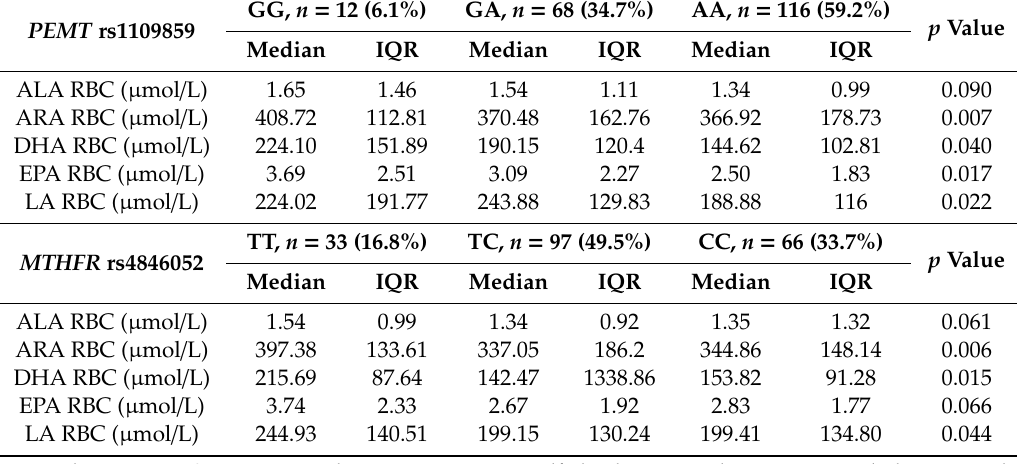
PUFA levels in RBC membranes grouped by PEMT and MTHFR genetic variation. The Kruskal–Wallis test was used to analyze di ff erences between genotypes. (Test is significant at p value ≤